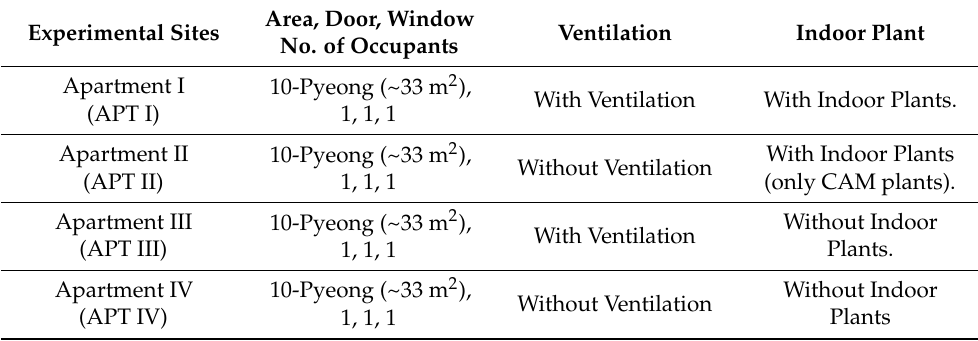
Table 2. Details about selected Plant species.